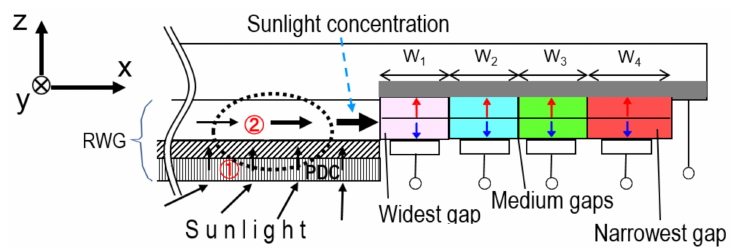
Figure 9. Cross-section of multi-striped orthogonal photon-photocarrier propagation solar-cell (MOP 3 SC) placed at the right edge of RWG. Region 1 is PDC, and Region 2 encircled by the dashed line is asymmetric DTSWG. RWG consists of DTSWG and PDC. W j ( j = 1–4) are the stripe widths of the semiconductors having di ff erent